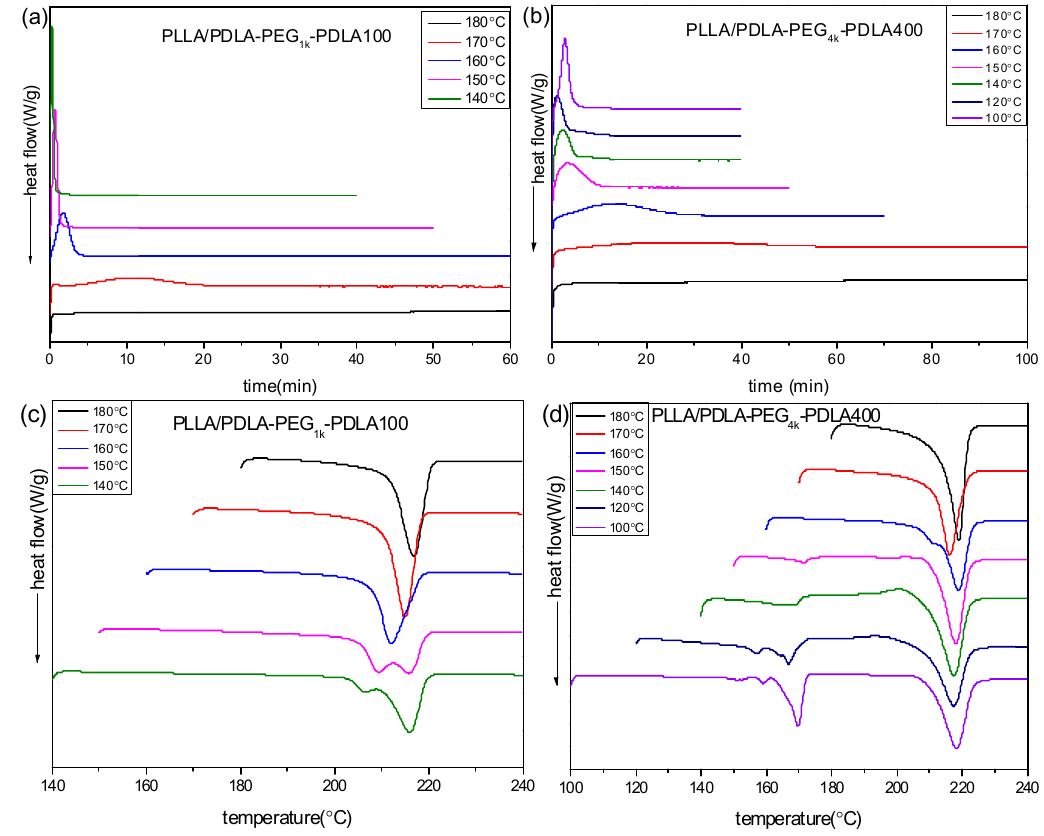
Figure 6. DSC curves of isothermal crystallization process ( a , b ) at different temperatures and subsequently heating processes ( c , d ): ( a , c ) PLLA/PDLA-PEG 1k -PDLA100 and ( b , d ) PLLA/PDLA- PEG 4k -PDLA400.